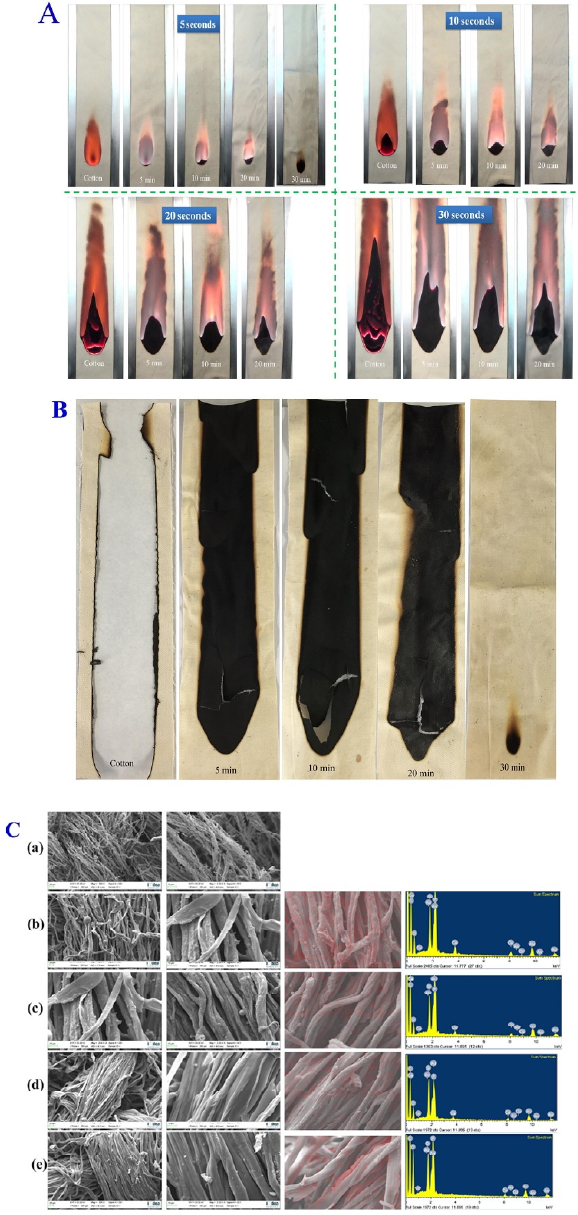
Figure 21. ( a ) Flammability test on untreated and treated cotton fabrics; ( b ) actual images of fabrics Figure 21. ( A ) Flammability test on untreated and treated cotton fabrics; ( B ) actual images of fabrics after flammability test; ( c ) SEM images and EDX spectra of cotton, (Reproduced from [151], with kind after flammability test; ( C ) SEM images and EDX spectra of cotton ( a ), cotton-5 min ( b ), cotton-10 min permission of Elsevier). ( c ), cotton-20 min ( d ) and cotton-30 min ( e ) at di ff erent magnification ( × 500, × 2000, respectively) after burning (Reproduced from [151], with kind permission of